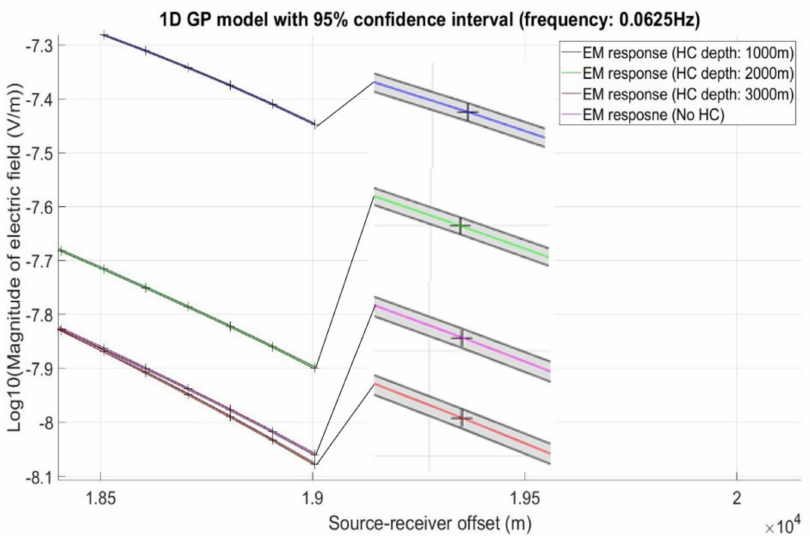
Figure 11. Zoomed-in scale of the 1D GP models for a frequency of 0.0625 Hz. The grey-colored bar is the 95% confidence interval (predictive variance) provided by the GP. The “cross” denotes the testing data involved in the GP